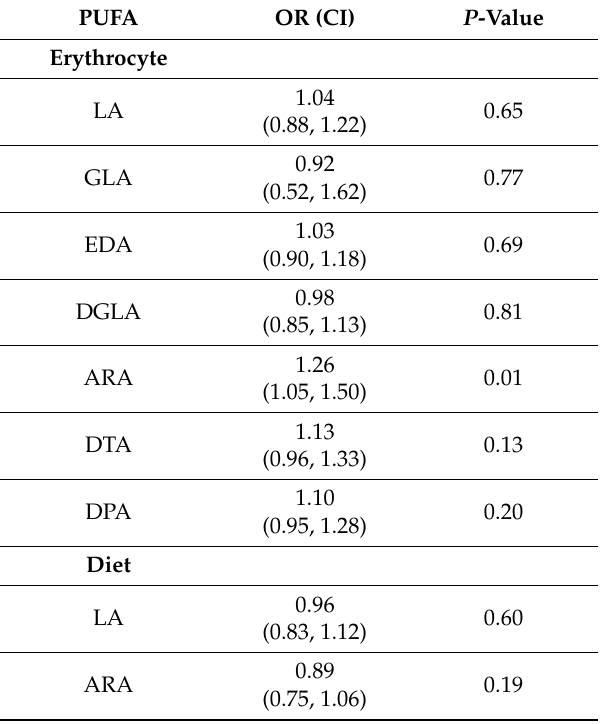
Table 5. Association between baseline erythrocyte n -6 PUFA composition (z-score) and risk of 2-year cognitive impairment among those considered to not have cognitive impairment at baseline ( n = 688) a,b,c . PUFA OR (CI) P